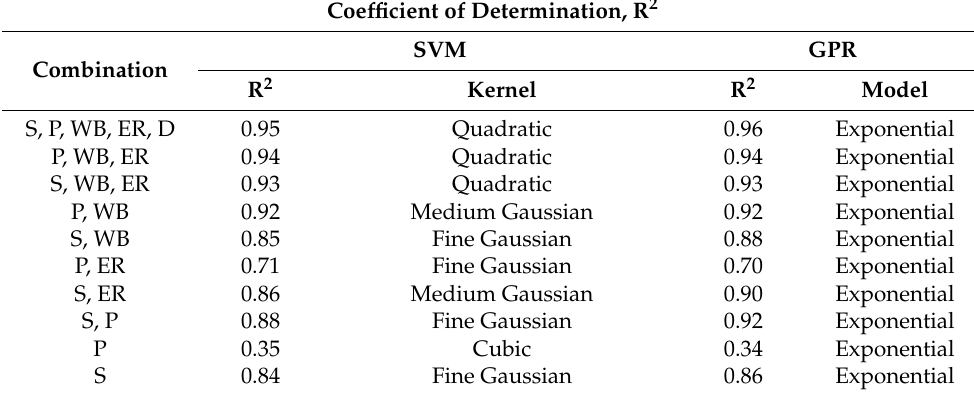
Figure 11. Correlation between actual fc,test and predicted fc,pred using different combinations of the five parameters from support vector machine analysis. ( a ) only UPV parameters: P, S, or P and S, ( b ) combination of UPV and one other parameter: P and WB, S and WB, P and ER or S and ER, ( c ) combination of UPV, ER and WB: P, ER and WB or S, ER and WB and ( d ) five all parameters: P, S, ER, D and WB. Note S is S-wave velocity, P is P-wave velocity, ER is electric resistivity, D is density and WB is water-to-binder ratio. Table 9. Coefficient of determination values (R-squared values, R 2 ) of training results from regression learner